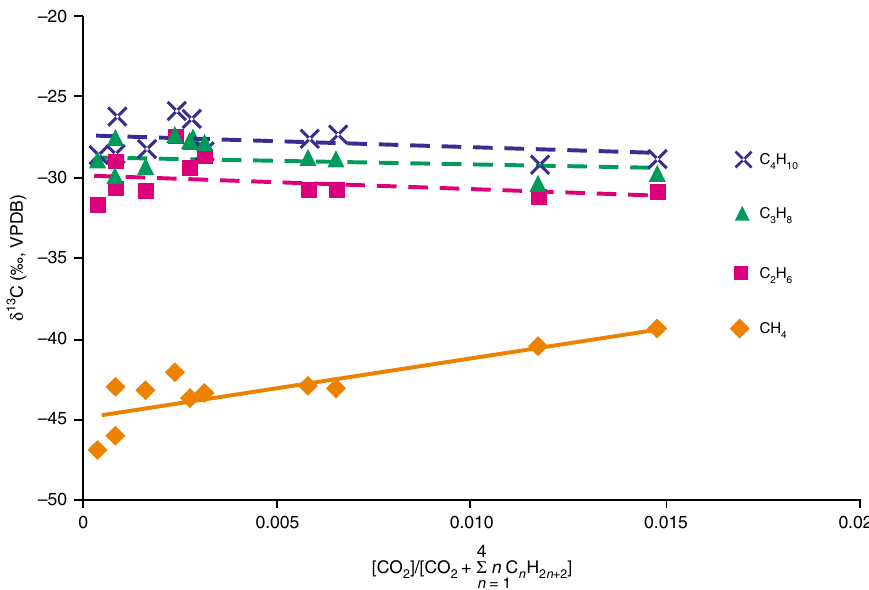
Fig. 6 Carbon isotopes of natural gases from T 1 b sandy conglomerate reservoirs plotted against [CO 2 ]/[CO 2 + ∑ n = 1 n C n H 2 n + 2 ]. The latter is a parameter estimating the extent of thermochemical sulfate reduction 39 . The error bar (±SEM) is smaller than the symbol